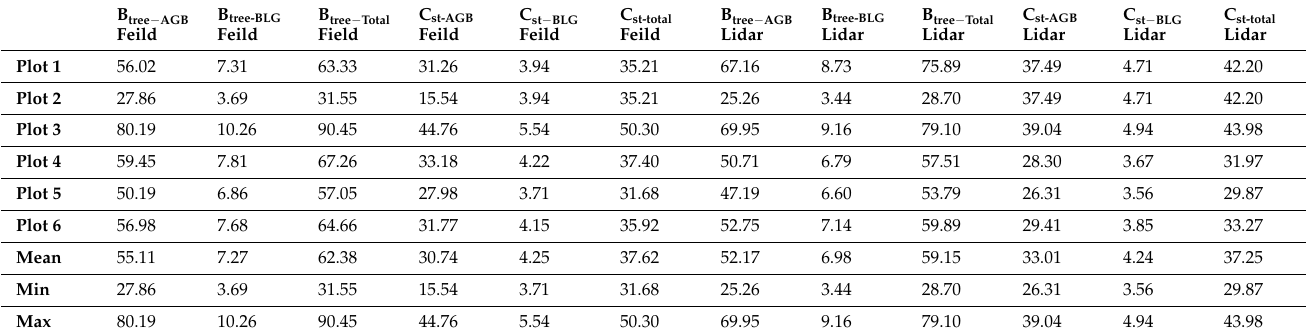
Table 7. Aboveground, belowground, and total biomass and carbon stock (Mg/ha) by plot and their mean, minimum, and maximum in the six plots. Where B tree − AGB is the plot Aboveground biomass in Mg/ha, B tree-BLG is the plot belowground biomass in Mg/ha, B tree − Total is the total plot biomass in Mg/ha, C st-AGB is the plot Aboveground carbon stock in Mg/ha , C st-BLG is the plot carbon stock in the belowground tissues and C st-total is the total plot carbon stock in